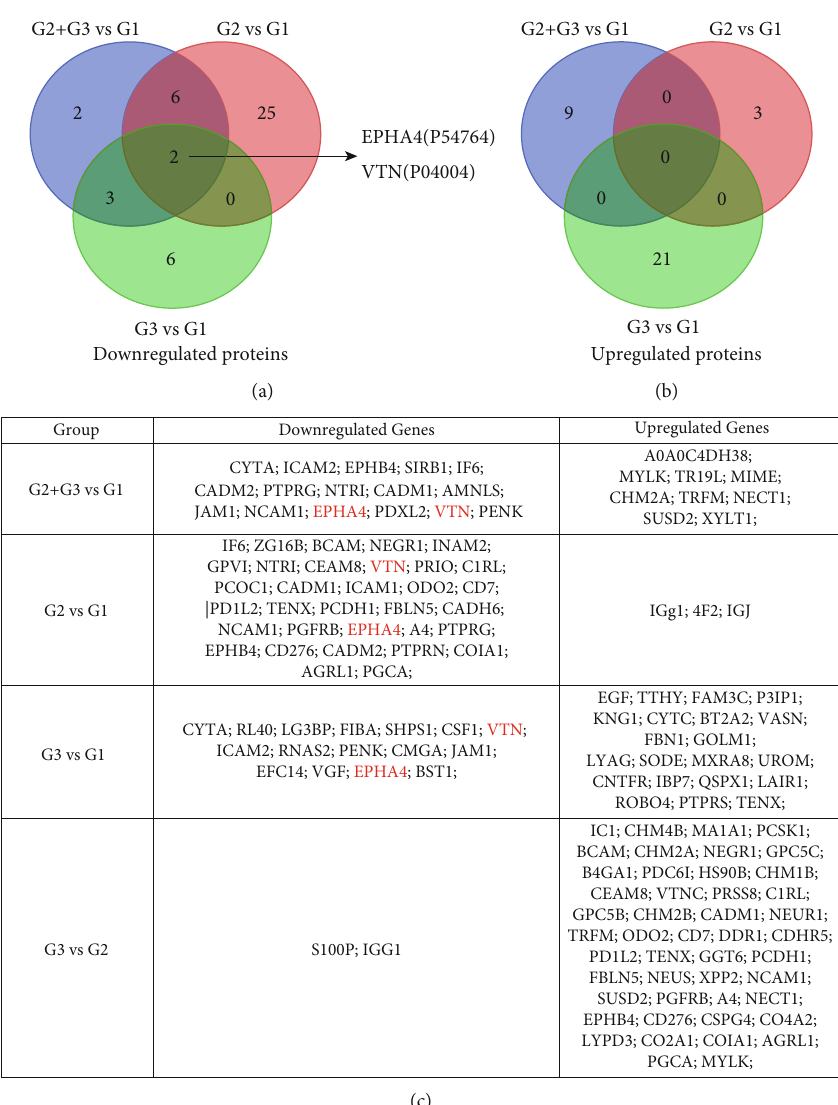
Figure 2: Identi fi cation of aberrant di ff erentially expressed proteins including downregulated and upregulated proteins. (a) Two aberrantly downregulated proteins EPHA4 and VTN, (b) but no aberrantly upregulated proteins are obtained by Venn diagram among the indicated groups (G1: healthy controls, G2: inactive JSLE patients, and G3: active JSLE patients). (c) The aberrant DEGs re fl ected by their matching proteins are listed in the indicated